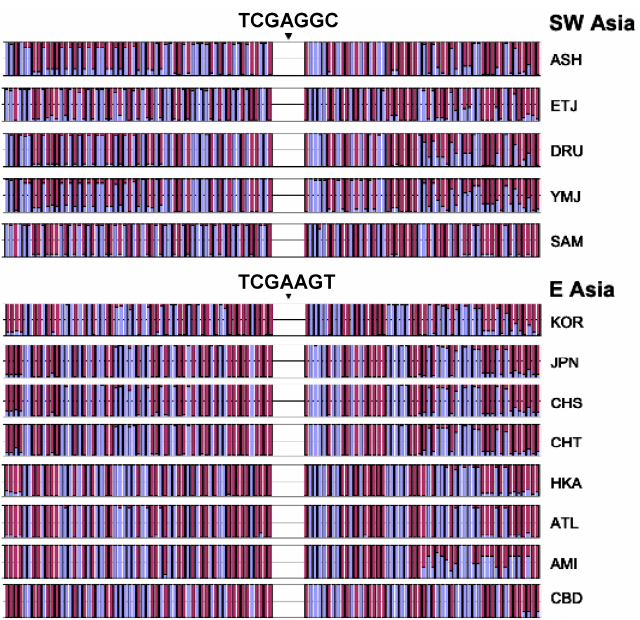
Figure 6. The allele profiles of SNPs in the flanking regions of the core haplotype under selection. Two different colors in each bar represent the relative percentage of two different alleles. Populations of the same geographic location tend to share similar allele profiles, while populations in two different areas apparently differ in allele profiles except occasional similarity.